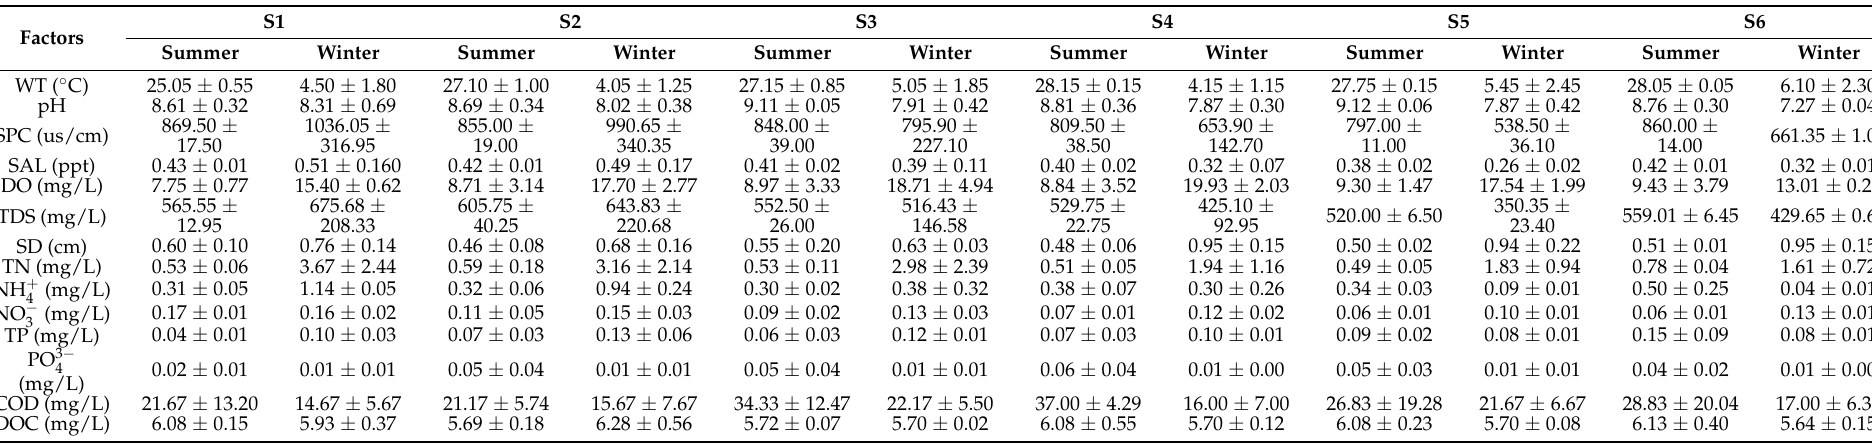
Table 1. Monthly values (mean ± SD, N = 6) of water parameters at six sampling sites in the Taiyuan urban section of the Fenhe